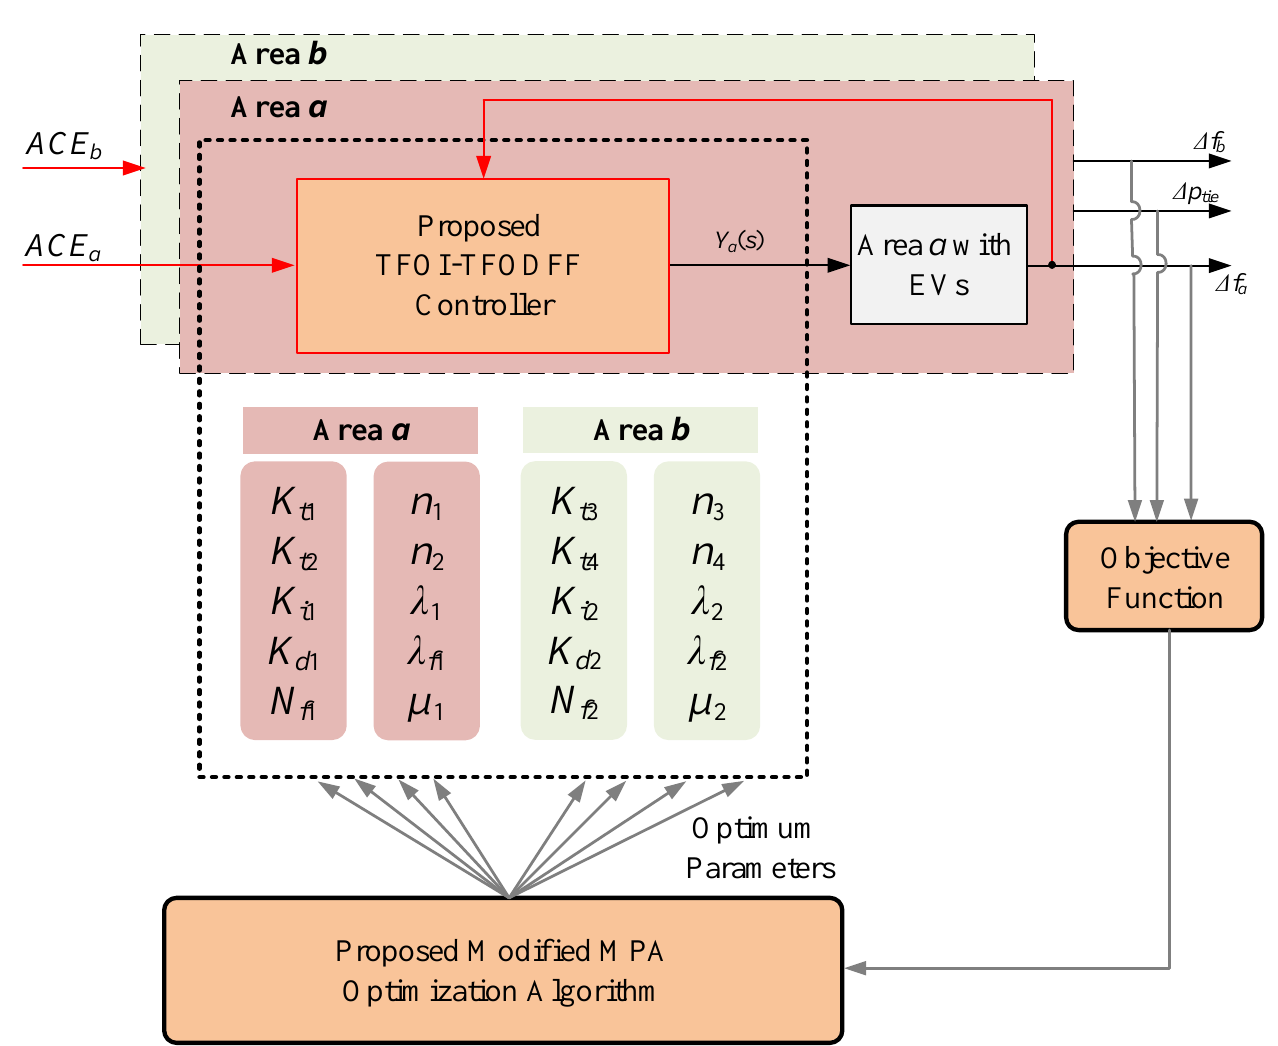
Figure 6. The proposed modified MPA optimizer-based parameters’ determination